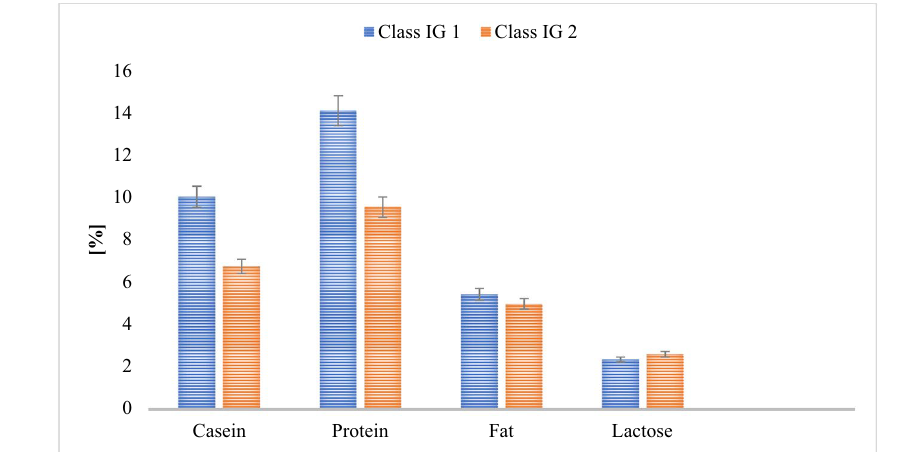
Figure 1. Changes in colostrum’s gross composition for different Ig